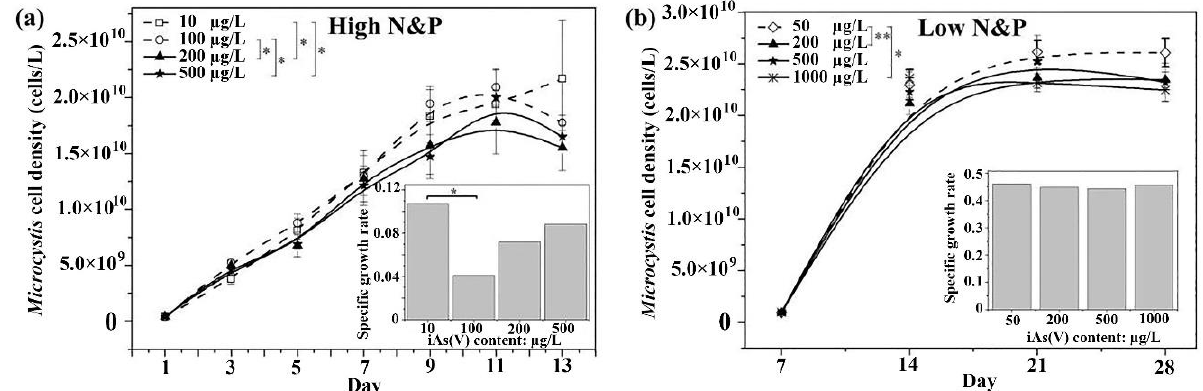
Figure 1. M. wesenbergii cell density varied with incubation time that was exposed with different iAs(V) concentrations in the high nutrient set in BG11 medium (N = 250 mg/L, P = 7.13 mg/L) ( a ) and adjusted low nutrient set (N = 1.5 mg/L, P = 0.3 mg/L) ( b ). The specific growth rate is imbedded. Note: Microcystis cell density with incubation time was compared between each of two groups of ambient iAs(V) concentrations. Significance levels below 0.05 (*) and 0.01 (**) are denoted in the figure.